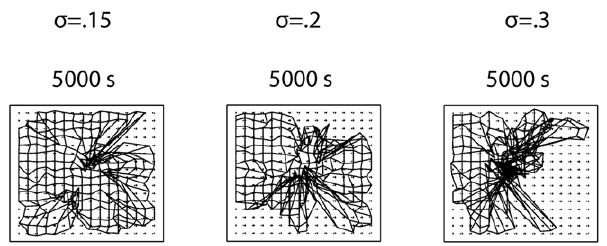
Figure 12. The retinogeniculate pathway still develops in the presence of waves generated by SACs with randomized refractory periods. The shape of retinal waves was altered by randomizing B R (see Figure 2), by drawing B R from a normal distribution centered at .09 with s set to .15, .2 and .3 (negative values were set to 0). The final state of the model retinogeniculate projection in each case is shown. Clearly, the width of the distribution affects retinogeniculate development, with the CoMs for many dLGN cells do not fully reach their targets on the ideal grid.